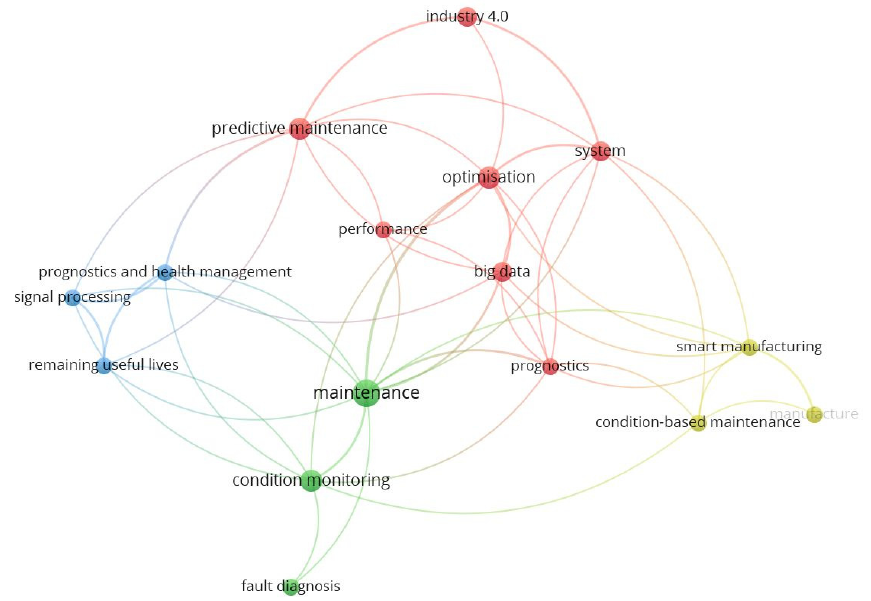
Figure 8. Keywords of co-occurrence analysis.